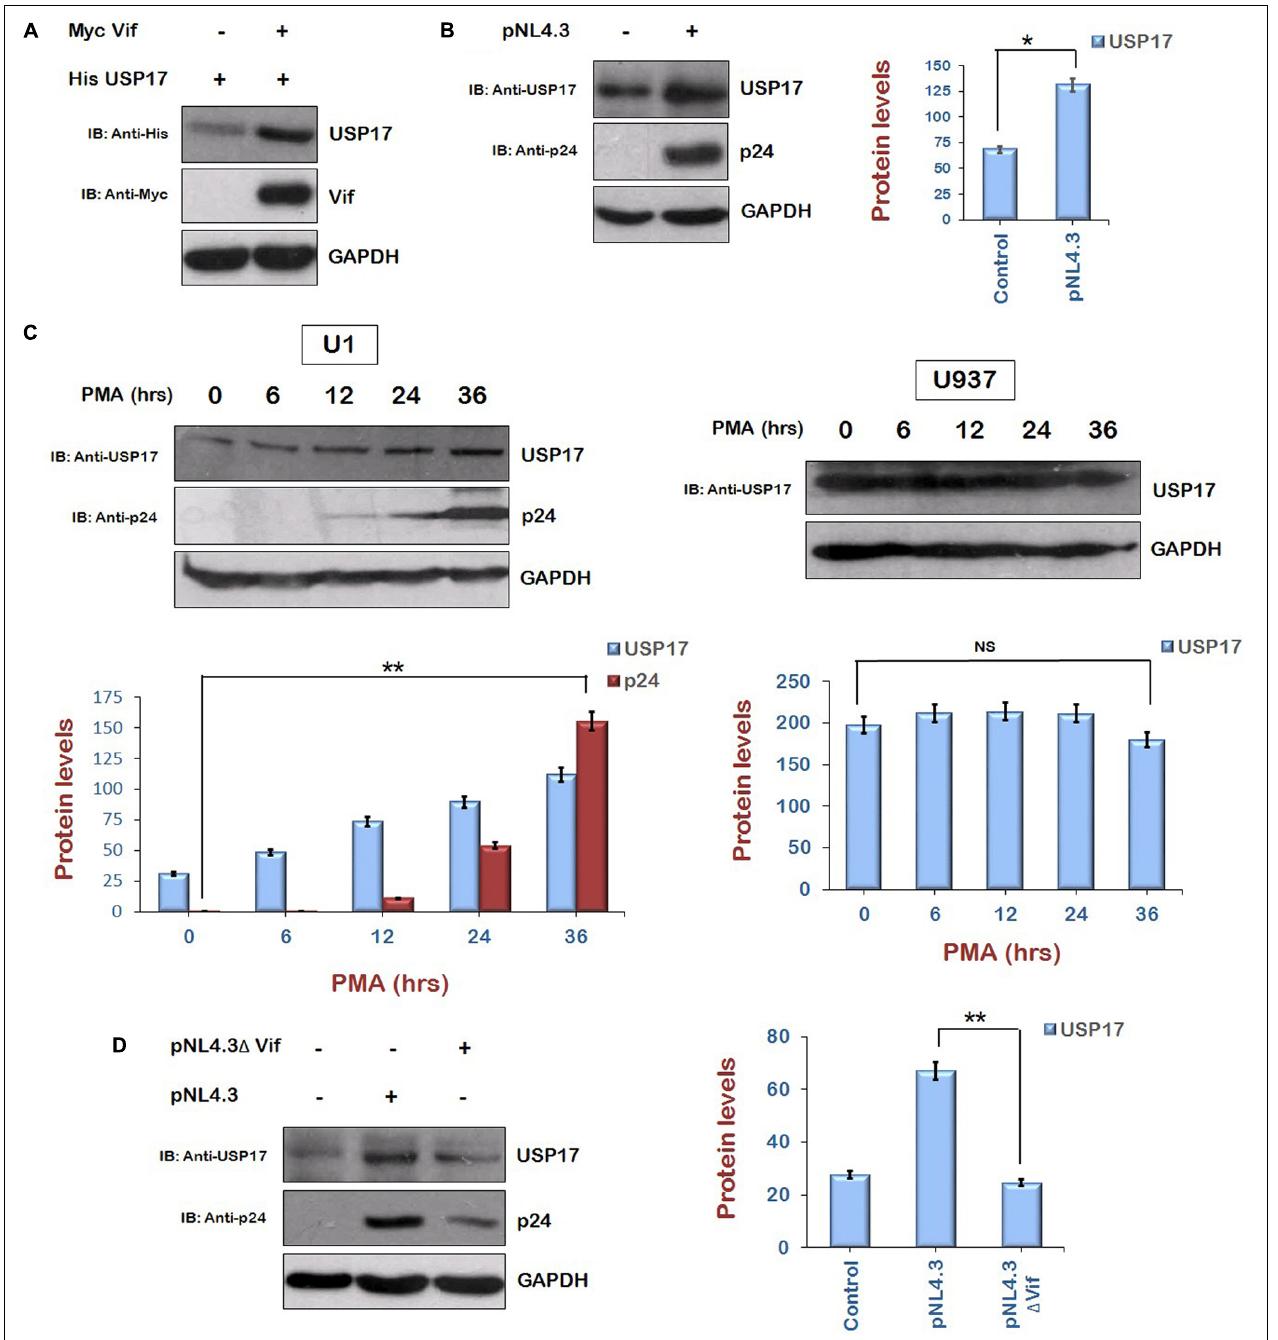
FIGURE 6 | Human immunodeficiency virus type 1 Vif increases the expression of USP17. (A) HEK-293T cells were cotransfected with His USP17 and Myc Vif expression plasmids for 24 h. Cell lysates were subjected to Western blot analysis using anti-His, anti-Myc, and anti-GAPDH antibodies. (B) HEK-293T cells were transfected with pNL4.3 plasmid for 24 h. Cell lysates were analyzed by Western blotting with anti-USP17, anti-p24, and anti-GAPDH antibodies. (C) U1 and U937 cells were treated with PMA (100 µ g/mL) for different time intervals as shown. Cell lysates were analyzed by Western blotting using anti-p24, anti-USP17, and anti-GAPDH antibodies. (D) HEK-293T cells were transfected with pNL4.3 or pNL4.3 (cid:49) Vif for 24 h. Cell lysates were analyzed by Western blotting with anti-USP17, anti-p24, and anti-GAPDH antibodies. GAPDH was used as loading control. Densitometry analysis was performed using ImageJ and shown as bar graph with error bars. Data obtained are presented as mean ± s.e.m. of three independent experiments. p -value was calculated by two-tailed t -test [* p < 0.05, ** p < 0.01, NS (not significant)].